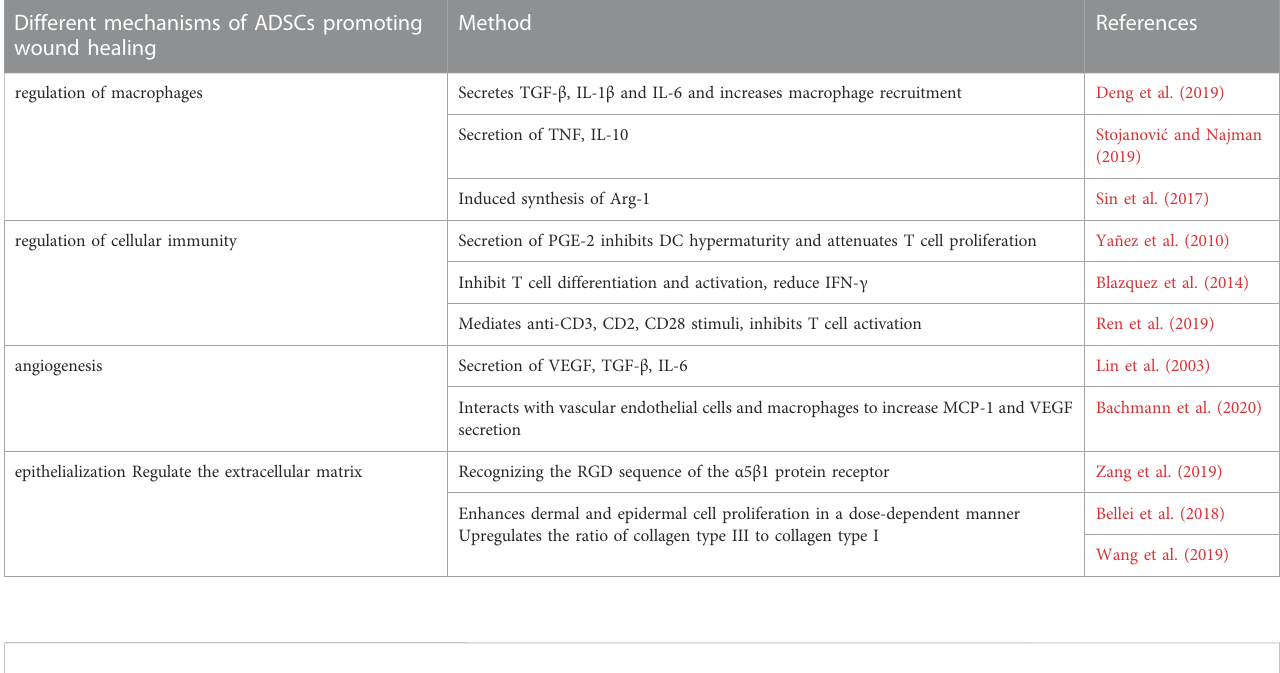
TABLE 1 Summary of the mechanism of ADSCs promoting wound healing. ADSCs are adipose-derived stem cells; TGF is transforming growth factor; IL is interleukin; TNF is tumor necrosis factor; Arg is arginase; PGE is prostaglandin; DC is dendritic cell; IFN is tumor necrosis factor; VEGF is Vascular endothelial growth factor; MCP is monocyte chemotactic protein; AT-Ex adipose tissue extracellular fraction.